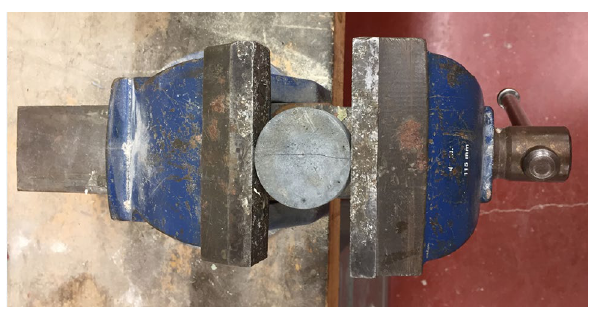
Figure 2. Cracking of mortar specimens using screw